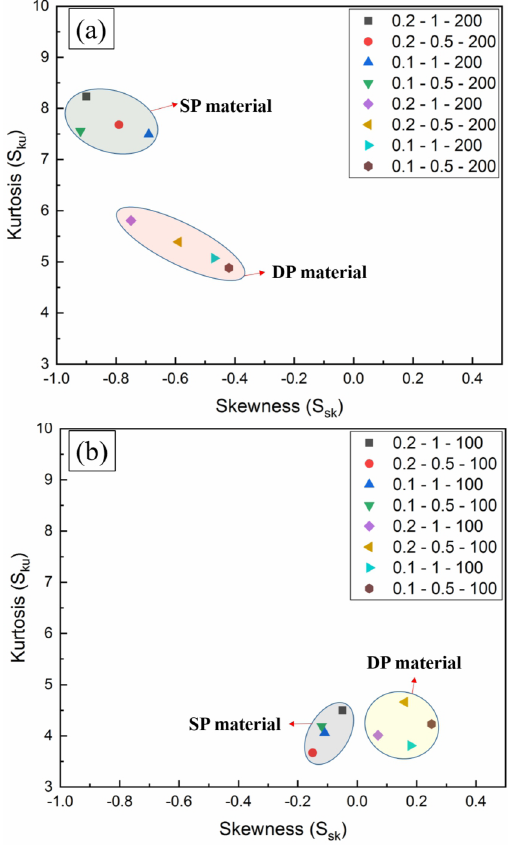
Figure 6. Morphological space of machined surfaces with (a) v = 200 m/min e (b) v c